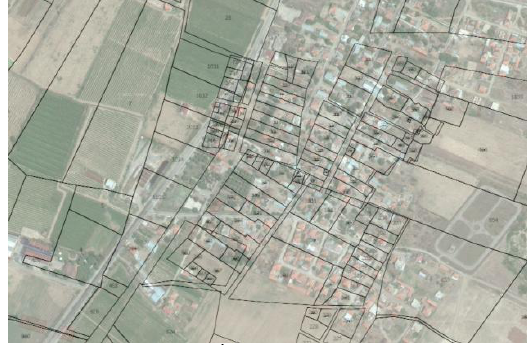
Figure 16. MEGSİS ve orthophoto web service Accesses from outside the organization for the safety of the system is provided with a static IP control. All institutions and organizations can benefit from the orthophoto web services . be performed (Figure 17).